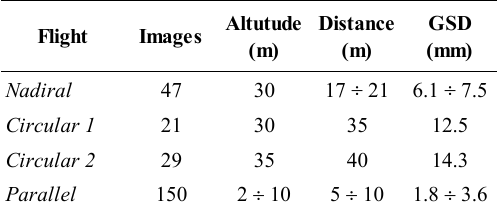
Table 1 . Main flight data of the UAV survey.